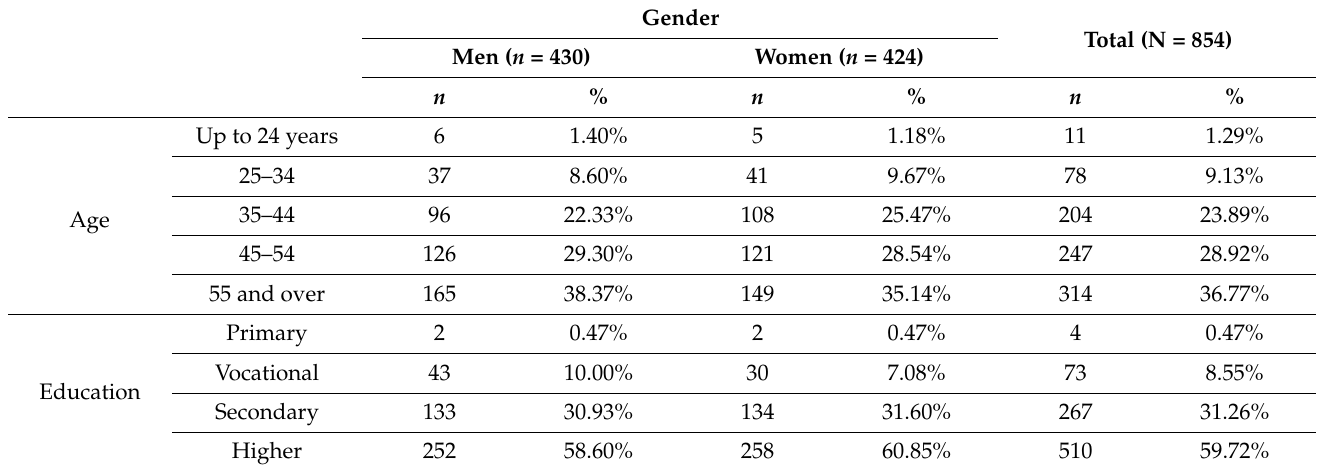
Table 1. Respondents by gender, age and